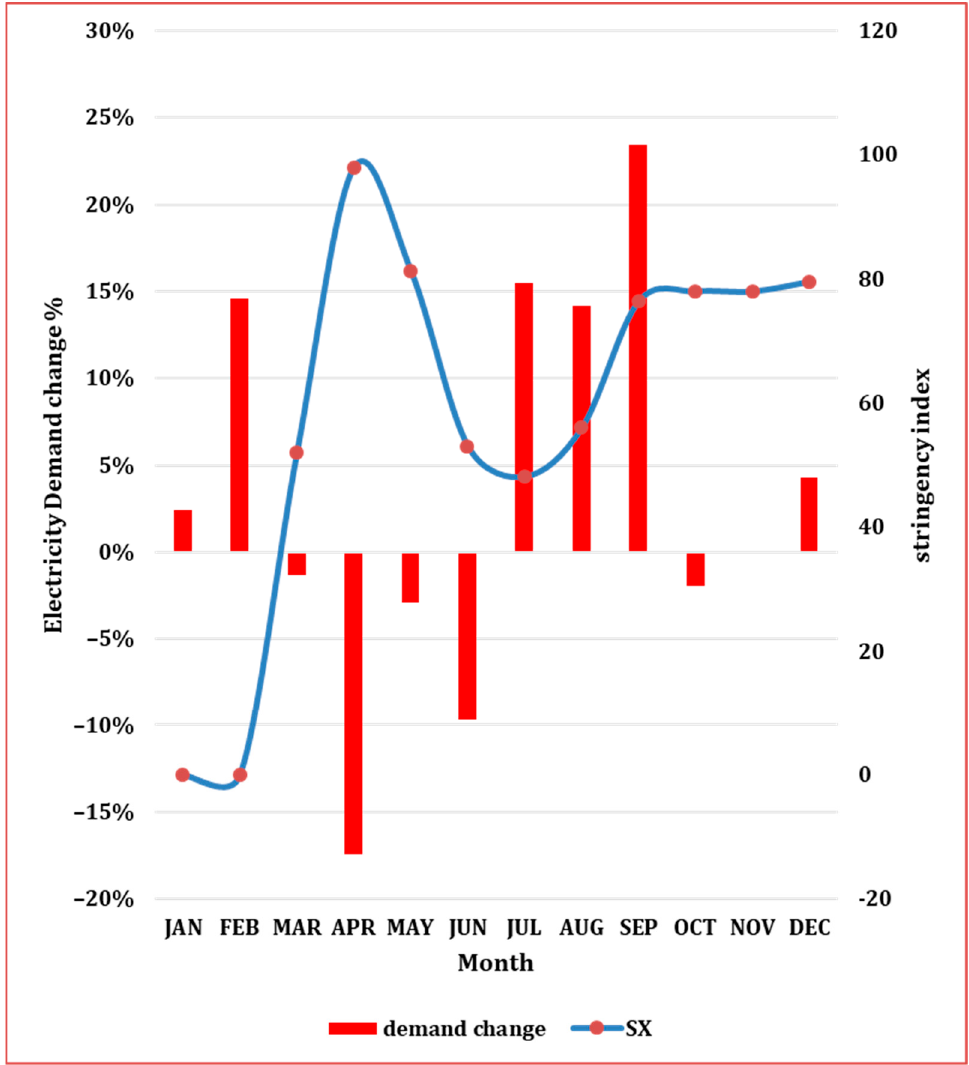
Figure 9. Monthly change in electricity demand between 2019 and 2020 at JEPCO’s area with the variation in stringency index.